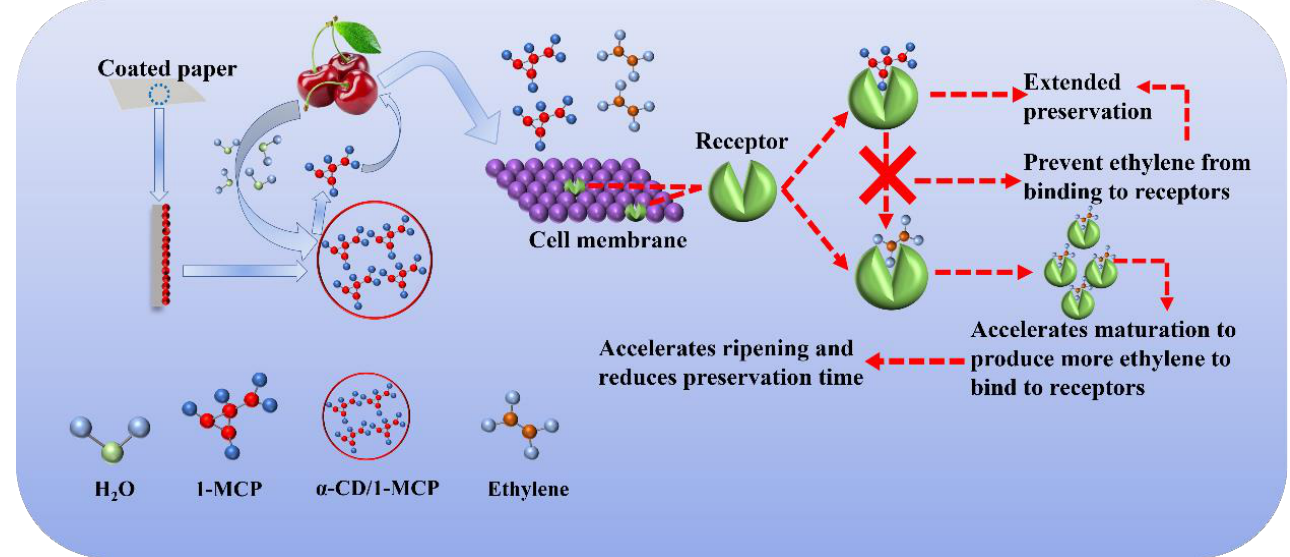
Figure 8. Schematic diagram of preservation of 1-MCP.